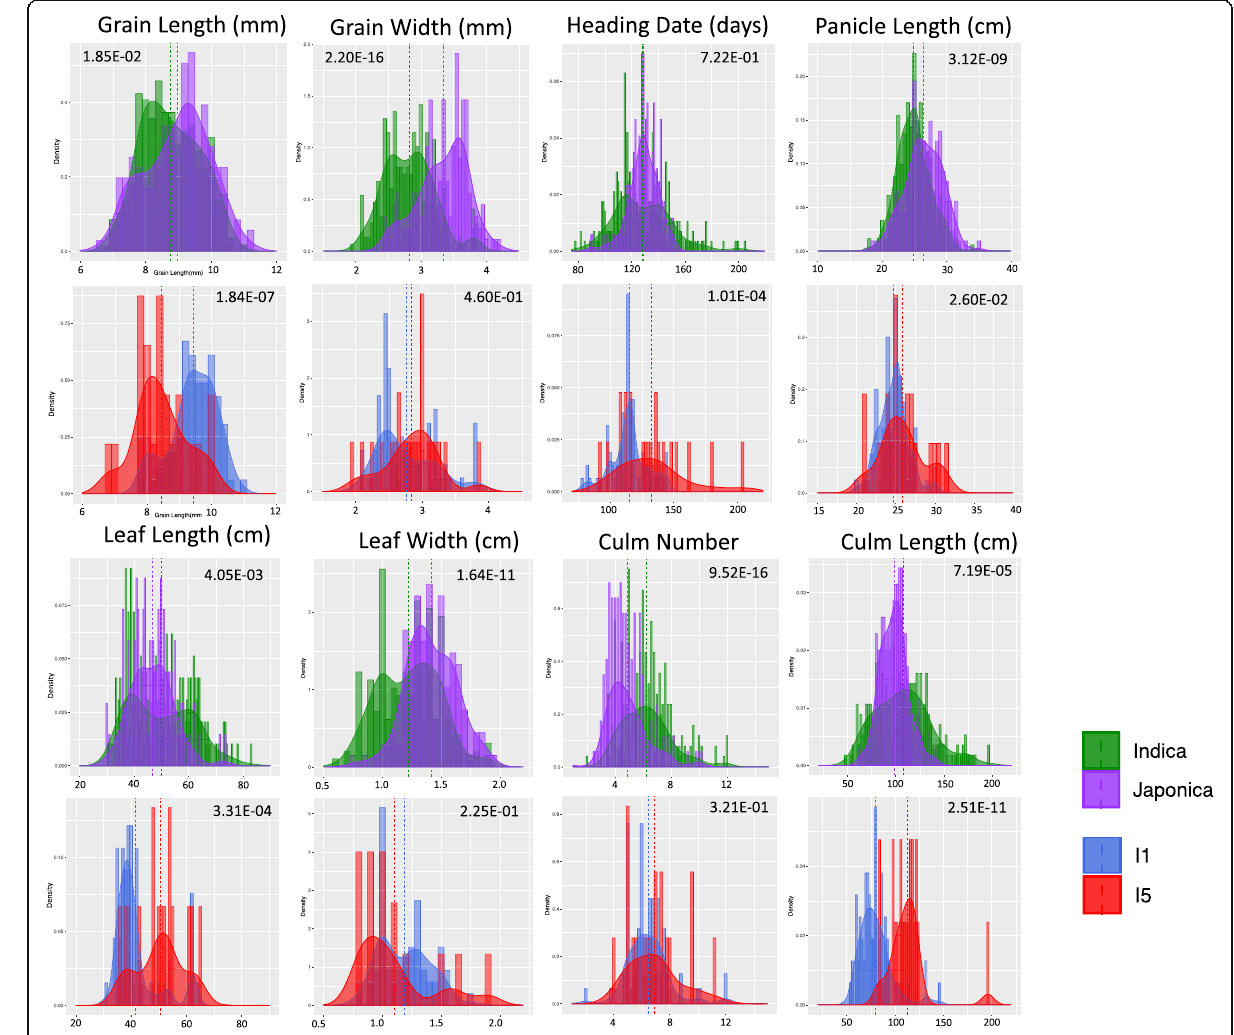
Fig. 4 Histograms comparing the Indica and Japonica subtypes and the I1 and I5 subpopulations. Histogram are shown for 8 of the 13 traits used in the GWAS analysis. The Japonica and Indica subtypes are shown in green and purple respectively and underneath a histogram is shown for a subset of the Indica values comparing subpopulations I1 and I5. The mean value is shown by a dotted line and the p value (T-test) is shown at the top of each plot. A ggpairs histogram and correlation plot is available for all 13 traits in Figs. S7 and